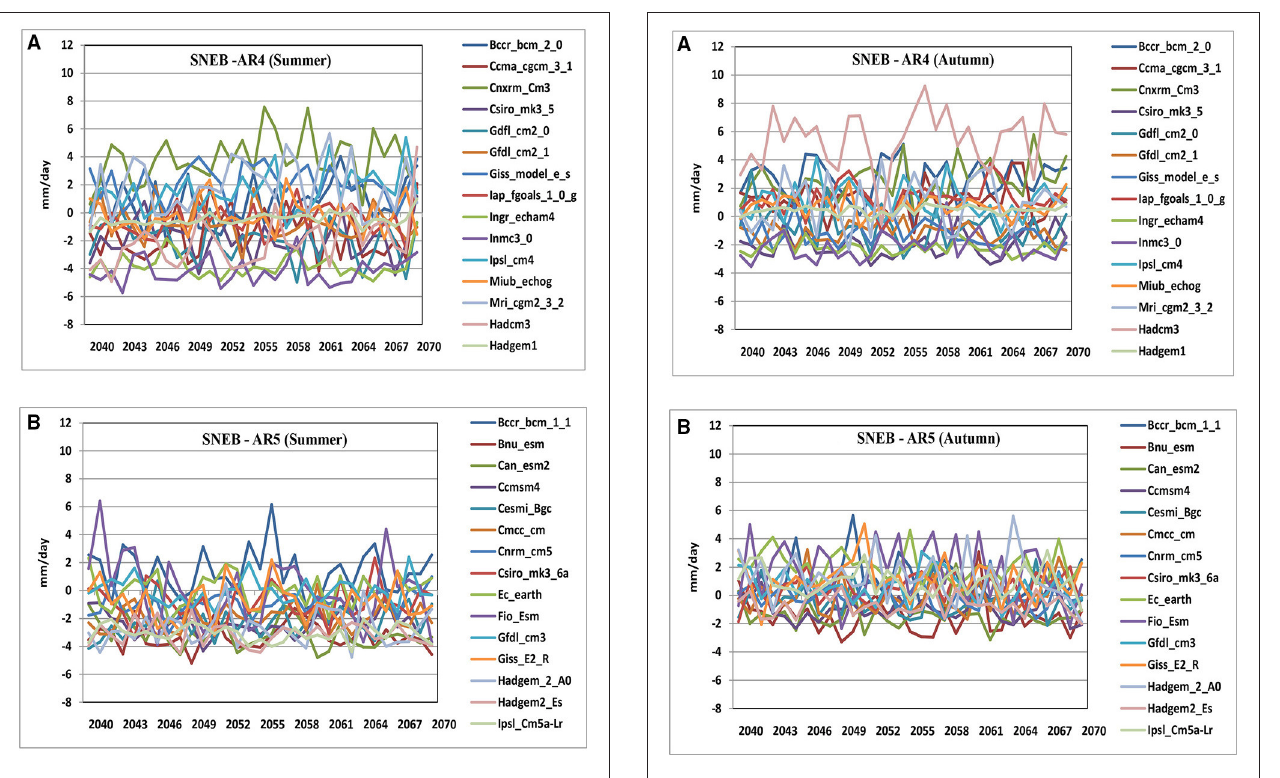
FIGURE 14 | As Figure 13 except for